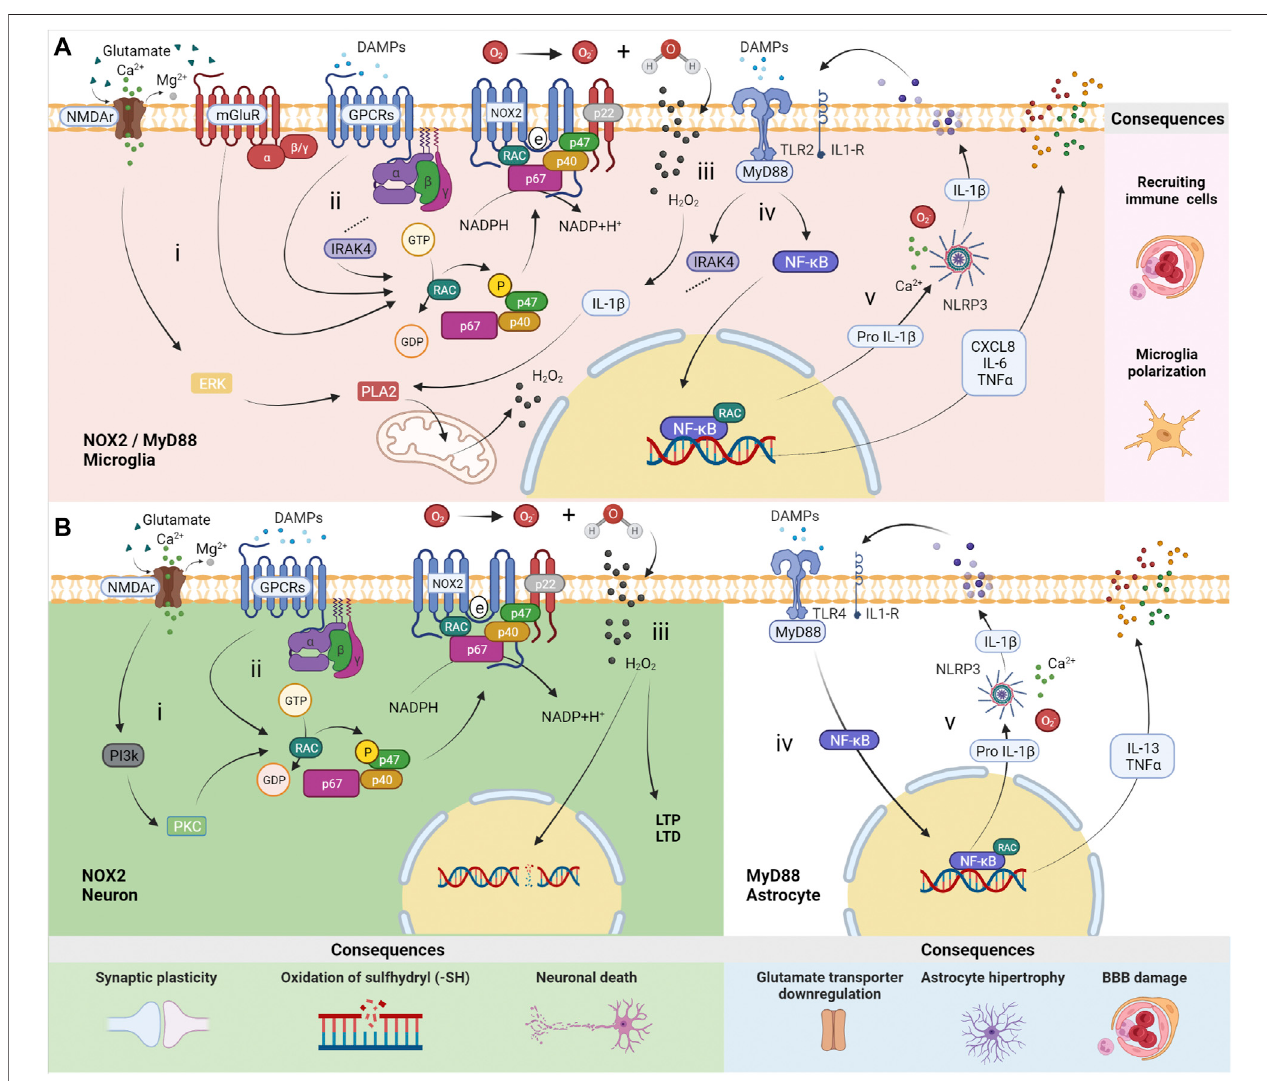
FIGURE 1 | Distinct roles of MyD88 and NOX2 in neurons, astrocytes and microglia. (A) In microglia, (i) N-methyl-D-aspartate receptors (NMDAr) promote a calcium in fl ow, which leads to the production of mitochondrial reactive oxygen species (ROS) via ERK-PLA2. The activation of metabotropic glutamatergic receptors from group II (mGluR3) and group III (mGluR4, 6, 7, 8) induces NOX2 activation throughout G i /G o alpha subunit. (ii) NOX2 can be activated by receptors of damage- associated molecular patterns (DAMPs) G-protein-dependent (GPCRs), i.e., N-formyl peptide receptors (FPRs) and P2Y receptors (P2YRs) via RAC, followed by phosphorylation of p47 phox (p47) and migration to the membrane along with p67 phox (p67) and p40 phox (p40), resulting in ROS production. (iii) H 2 O 2 produced from hydrogen and O 2 can cross membranes to participate in biochemistry reactions. (iv) Stimulation by DAMPs or cytokines throughout Toll-like Receptor 2 (TLR2) and interleukin-1 receptor (IL-1R), activates an intracellular signaling pathway involving the protein adaptor myeloid differentiation primary response 88 (MyD88). Speci fi c consequences occur in microglia, such as NOX2 activation via IRAK4-RAC pathways. (v) NF- κ B/RAC transcription factors promote the expression of chemokines CXCL8, IL-6, TNF α , and Pro IL-1 β . The latter is transformed into mature IL-1 β by the NLRP3 in fl ammasome dependent on calcium and ROS. The consequences are immunecell recruiting and microglia polarization. (B) Activation ofNOX2 inneuronsoccurs (i)byNMDAr (containing subunit GluN2B) via PI3K-PKC and/or (ii) byDAMPs receptors(FPRsandP2YRs).(iii)H 2 O 2 producedfromhydrogenandO 2 induceslong-termpotentiation(LTP)andlong-termdepression(LTD.)inphysiologicalsituations. However, a high concentration of ROS, e.g., in status epilepticus (SE), results in neural DNA damage by oxidation of sulfhydryl compounds ( – SH) and cell death due